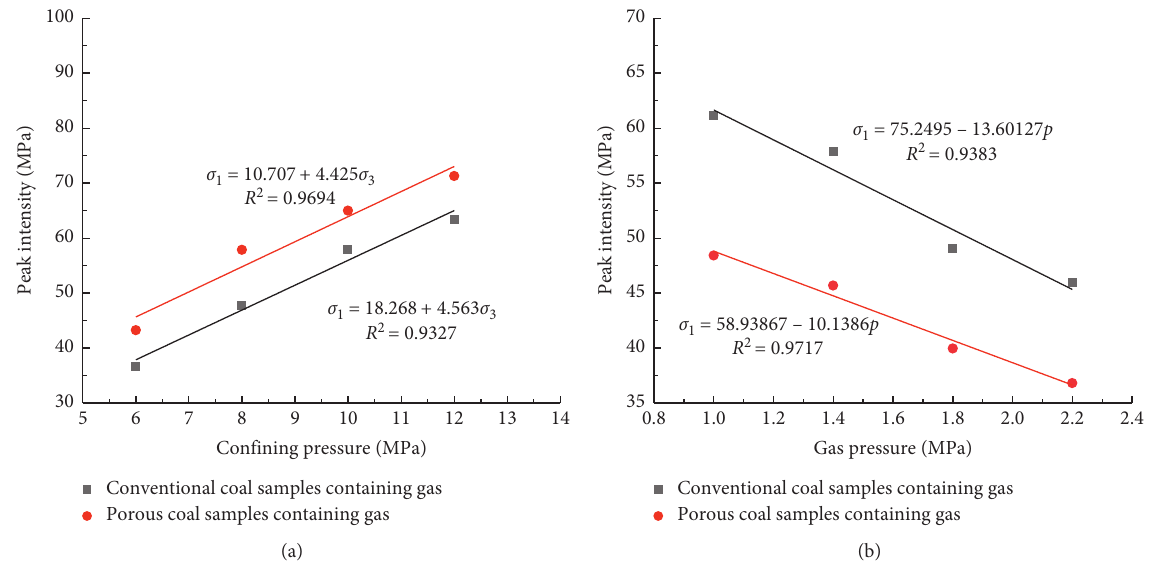
Figure 2: The variation of peak strength of porous and conventional gas-bearing coal samples with confining pressure or gas pressure: (a) variation with confining pressure; (b) variation with gas pressure change.